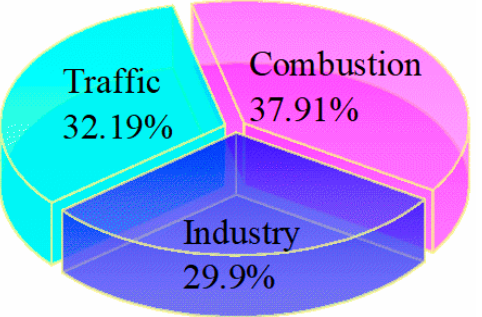
Figure 3. Contributions of identified sources to PM 2.5 -bound metal based on the PMF model in Yuci College Town, Shanxi, China.